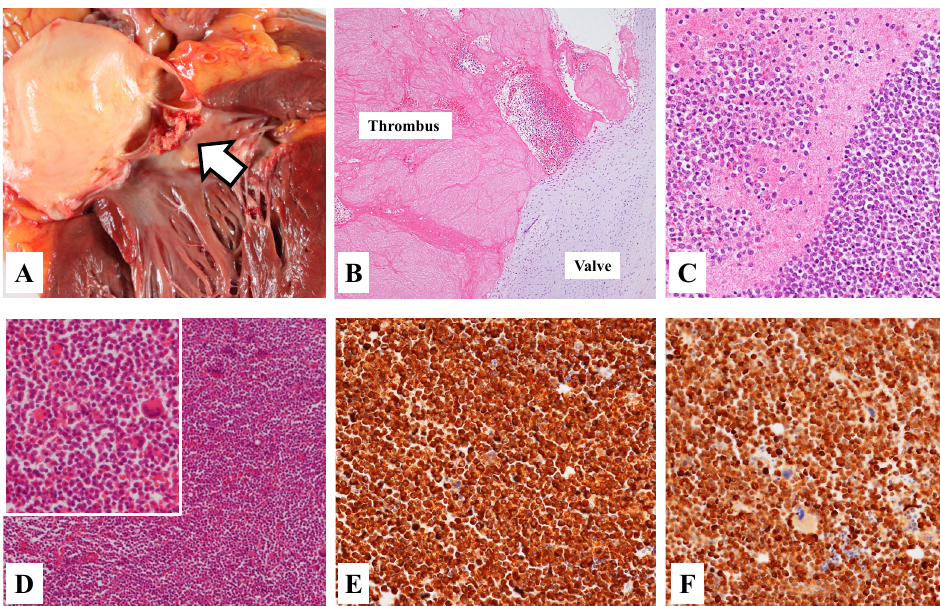
Figure 3. Macroscopic and microscopic appearances in an autopsy of our patient. Macroscopic finding of the heart showed the vegetation ( A , arrow). Histological finding revealed the evidence of the thrombus attached to the arterial valve ( B , H&E staining). Moreover, the close-up finding showed the aggregation of abnormal leukocyte cells in the thrombus ( C , H&E staining). Histological finding of the femoral bone marrow showed massive abnormal leukocyte cells ( D , H&E staining). From immunohistochemistry method, most abnormal cells were positive to myeloperoxidase (MPO) ( E ) and MIB-1 ( F ).